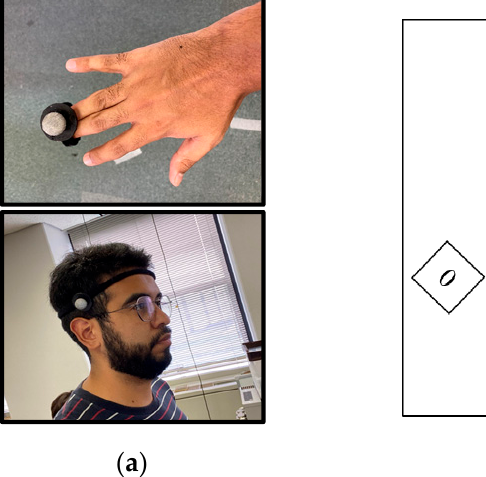
Figure 5. Implementation setup: ( a ) markers’ positions on the participant: hand for computing dis- tance and head as reference for android’s reaction; ( b ) implementation setup using an OptiTrack system and three approaching angles: front, left, and right.